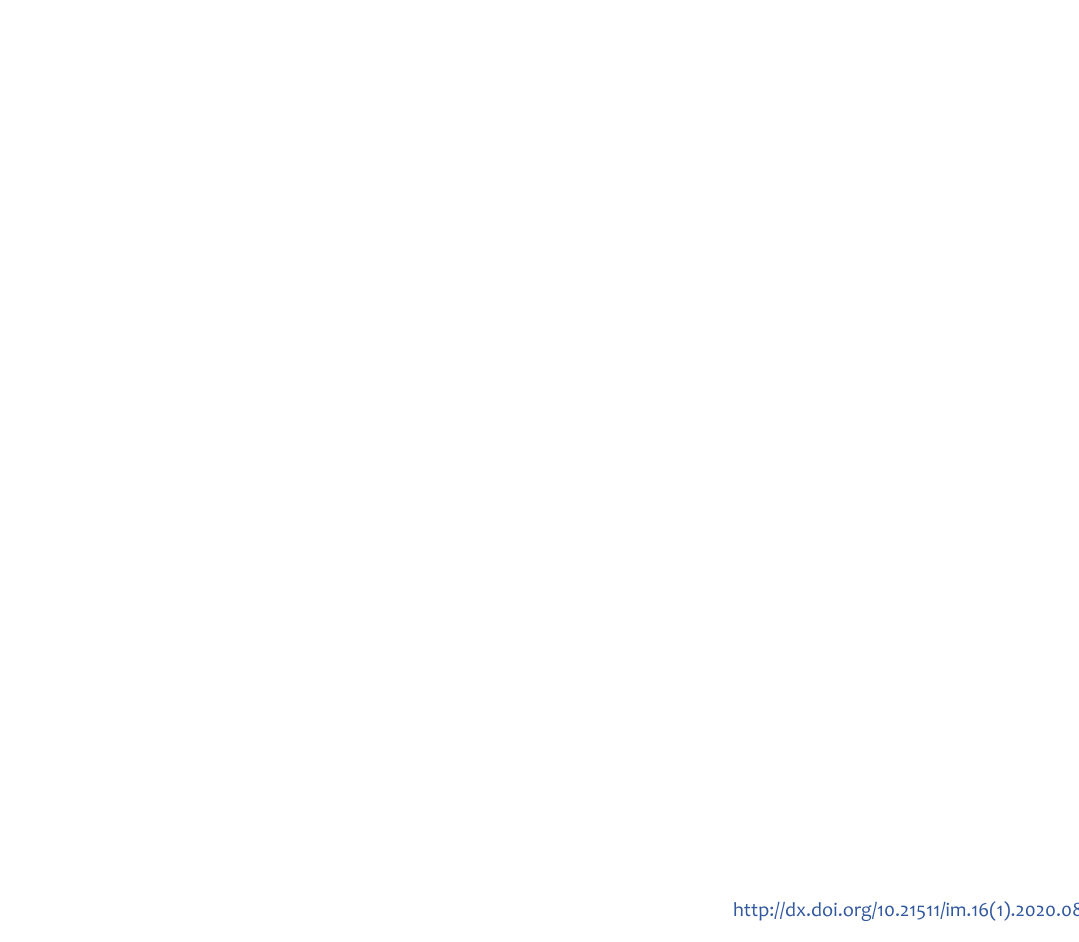
Table A1. Market shares of top 10 exporters by animal products Animal product Countries in the descending order of